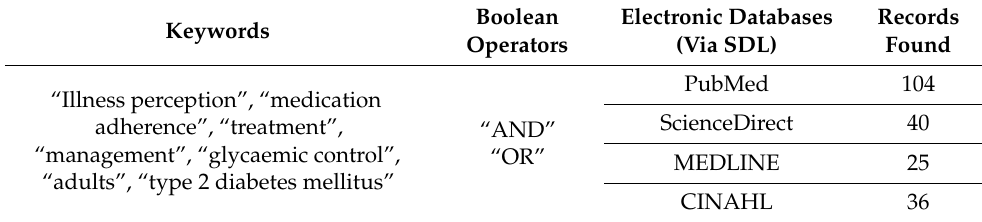
Table 2. Keywords, Boolean Operators, Electronic Databases, and Records